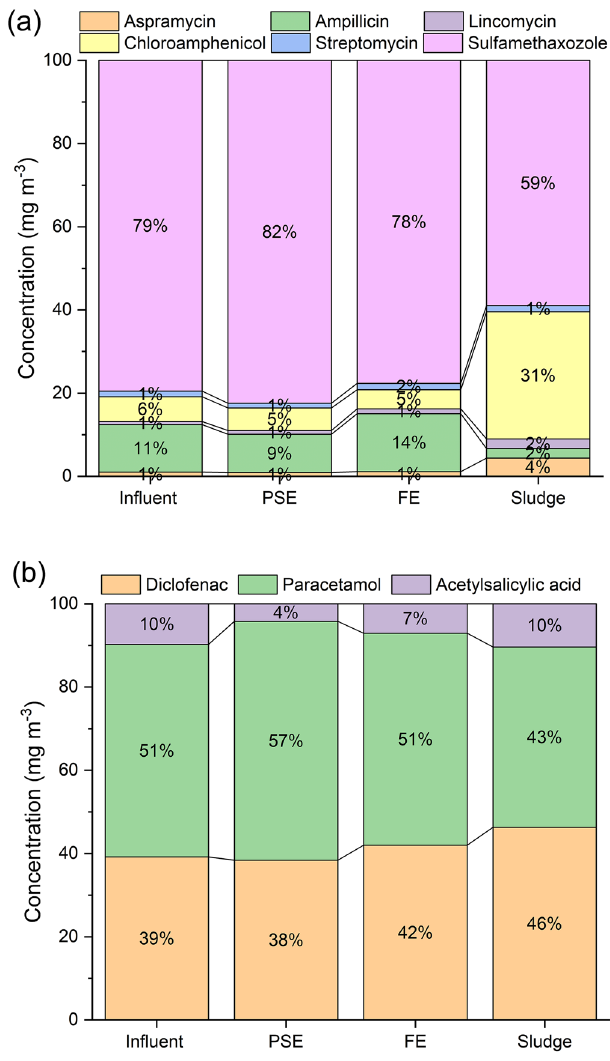
Figure 3. Distribution patterns of the pharmaceutical compounds in the different stages of STP.